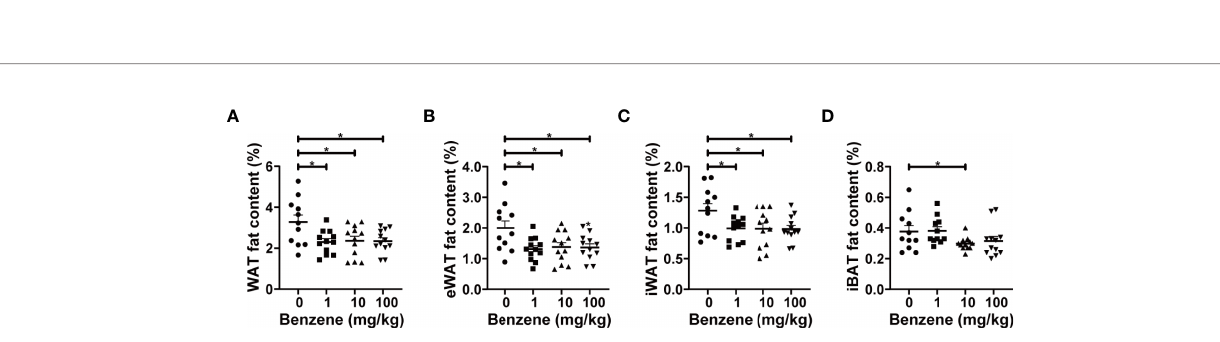
FIGURE 3 | Effect of benzene on fat content. The body fat distribution was re fl ected by the fat content of representative adipose depots (A – D) including epididymal white adipose tissue (eWAT), inguinal white adipose tissue (iWAT), white adipose tissue (WAT) and interscapular brown adipose tissue (iBAT). All parameters were measured after four-week exposure. Data are presented as mean ± SD (n = 11-12). One-way ANOVA were performed; * p < 0.05 (compared to the control